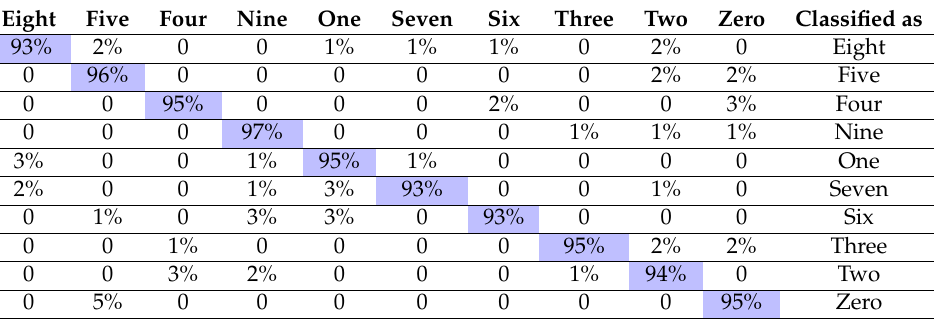
Confusion matrix of n -fold cross-validation (8-fold) results for Urdu handwritten numeral